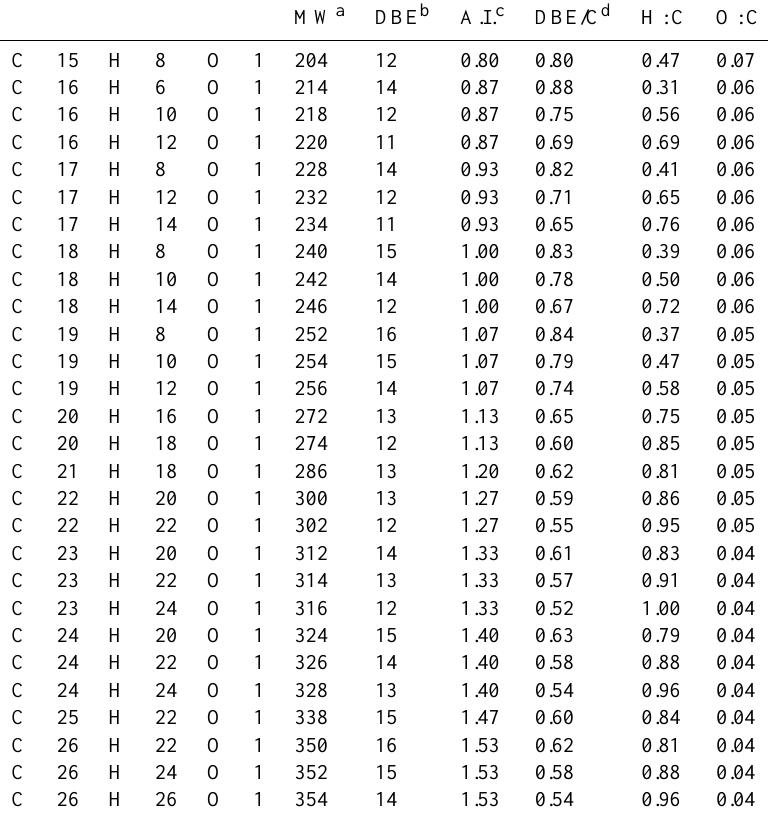
Table 3. Proposed neutral molecular formulas of the condensed aromatic